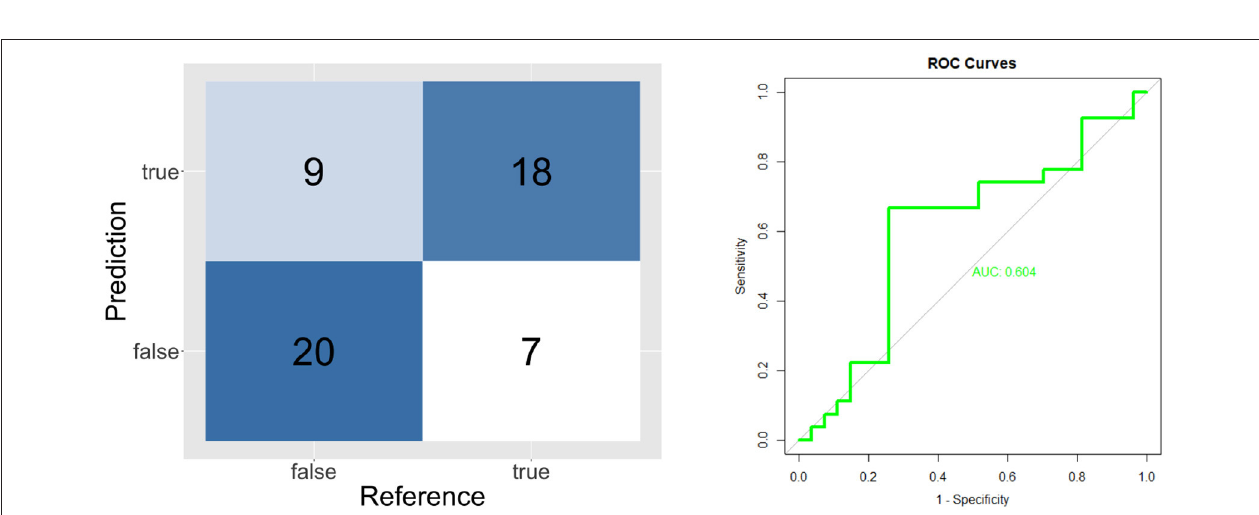
FIGURE 5 | Confusion matrix and ROC curve for short known message’s model (TT and FF).